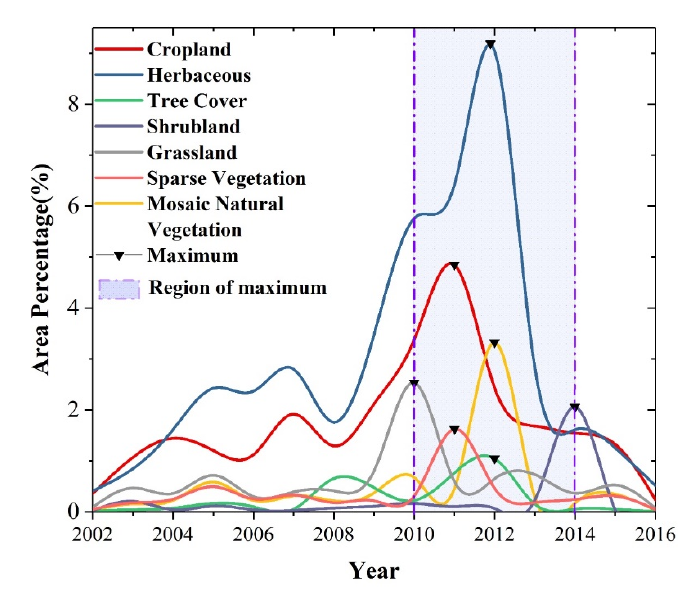
Figure 9. Area percentages of negative changes in each vegetation area during 2000–2018.